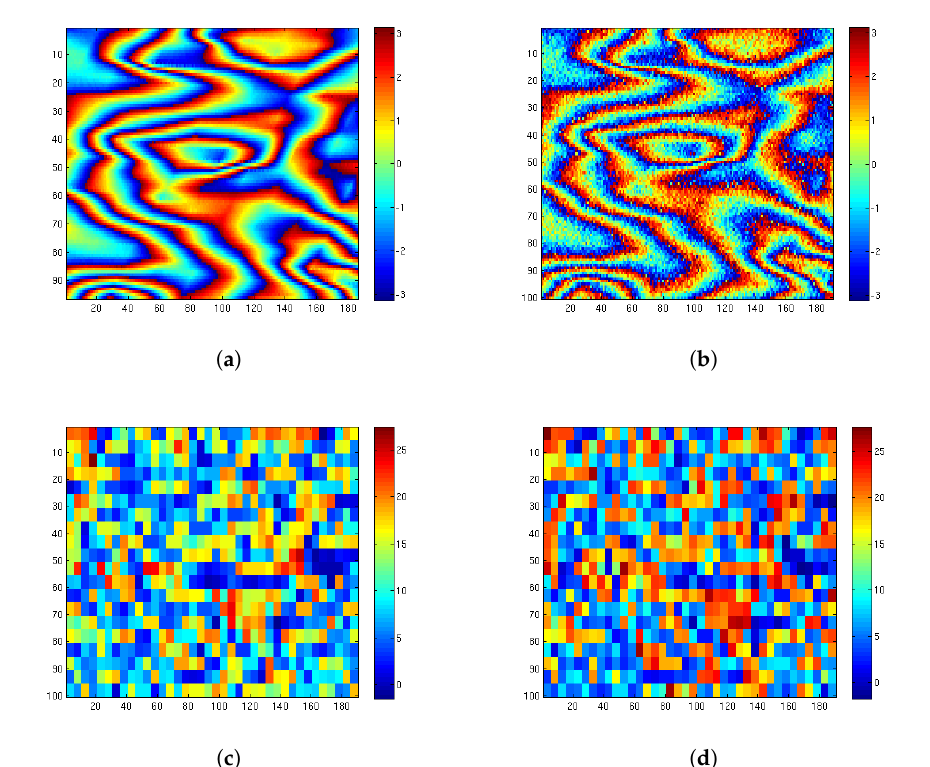
190 patch of a simulated interferogram: ( a ) simulated fringe pattern; Figure 9. Extracted 100 × ( b ) simulated data corrupted by an additive white noise with standard deviation equal to 0.5; ( c ) Peak Signal-to-Noise Ratio (PSNR) map for K-SVD; (d) PSNR map for ProK-SVD.